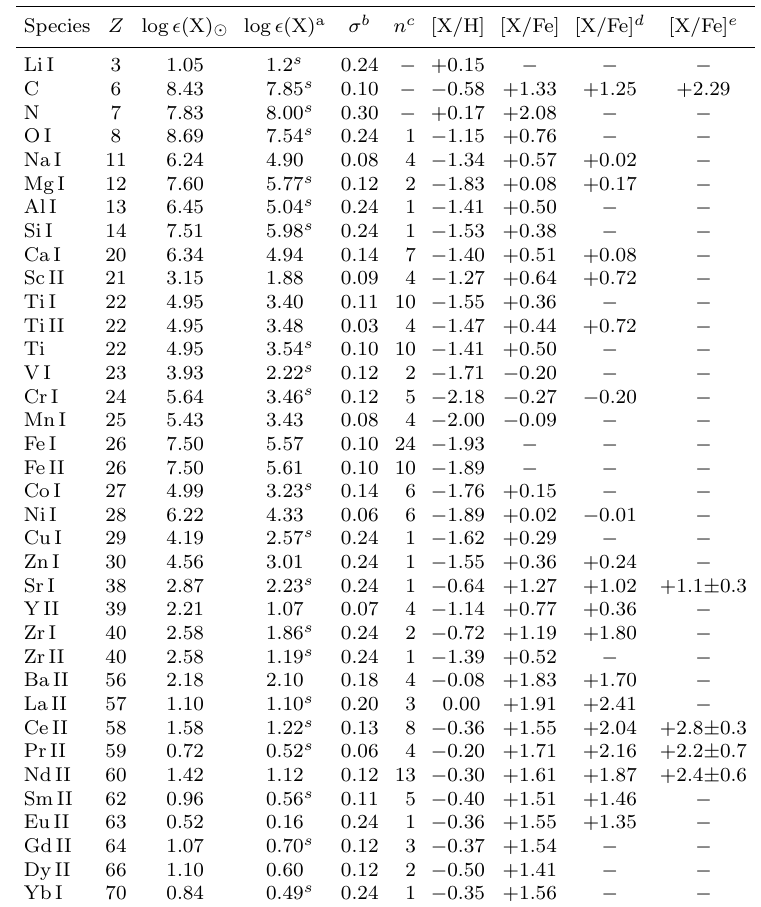
Table 3. The mean absolute and relative abundances in the atmosphere of HD 209621 calculated using T eff = 4400 K, log g = 1 . 0 (cgs), and ξ t = 1 . 9 km s − 1